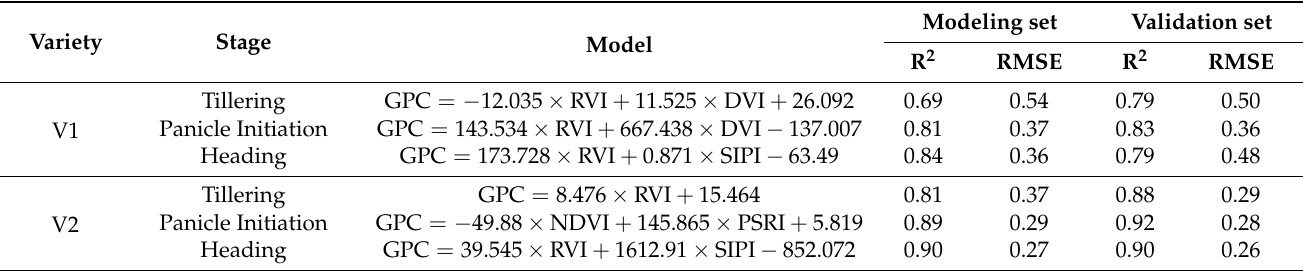
Table A4. Grain protein content (GPC) regression models and their accuracy for two rice varieties at three different growth stages ( n =